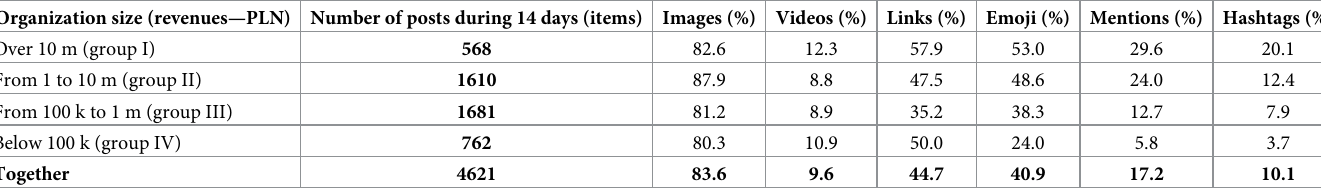
Table 1. Rate of communication tool utilization in Facebook posts by organizational